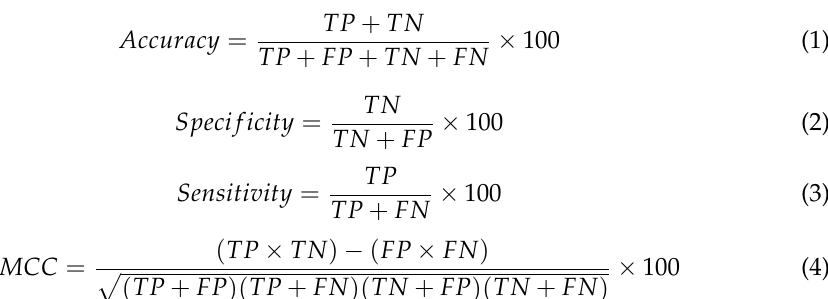
Figure 6. Model architecture in this study. After PC6 encoding, protein sequences will go through every layer in this model.